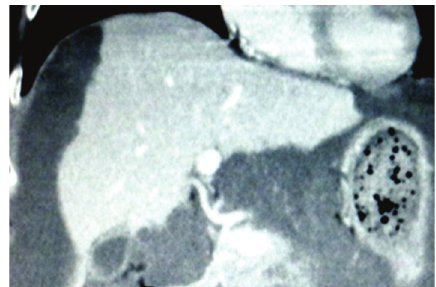
Figure 6: Enhanced CT scan shows tumor located in the hilar, cystic, and umbilical plate, and tumor extended in Glisson’s capsule.